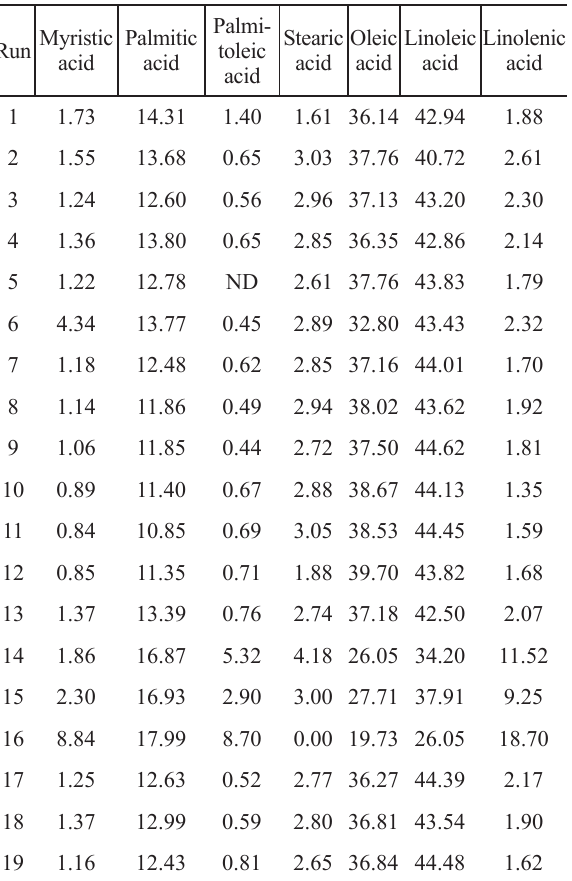
Table 4 – Effect of SCO anin content in methanol